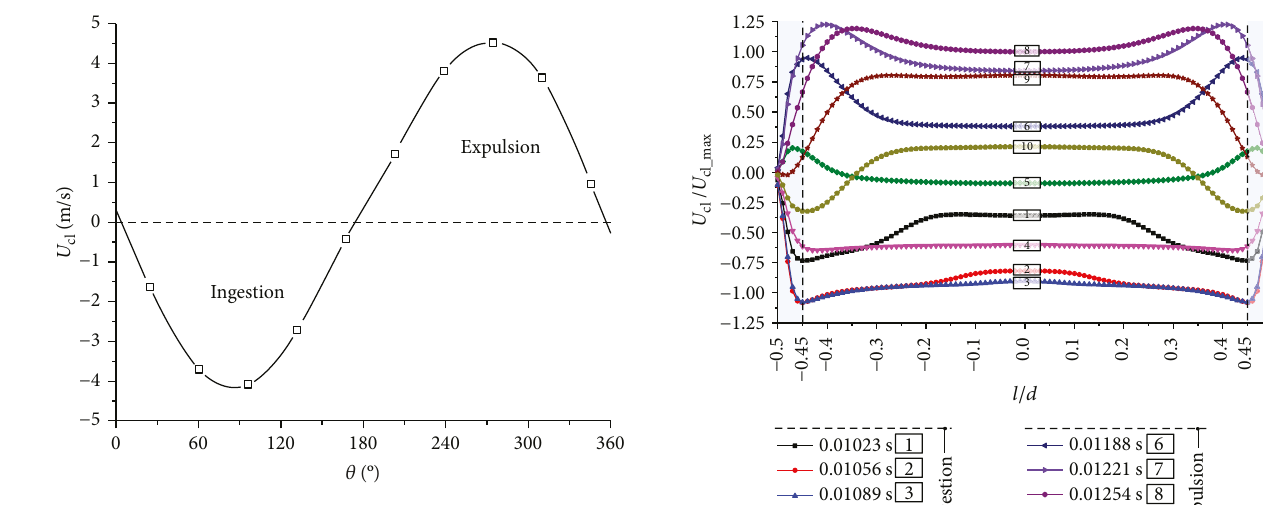
Figure 5: Velocity distribution at the nozzle exit centerline in the 4th cycle.